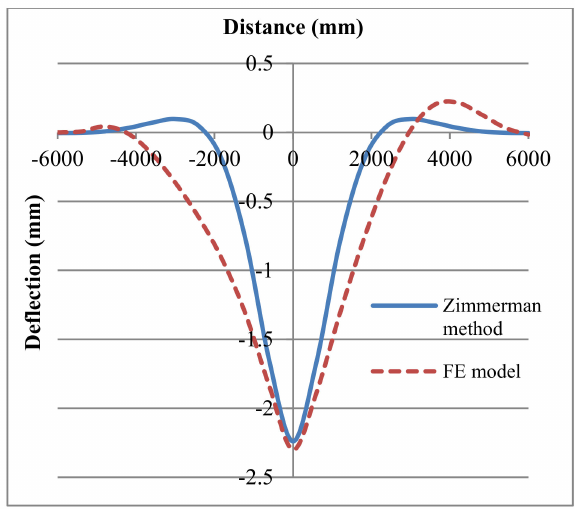
Figure 7. Vertical deflection values of rail.